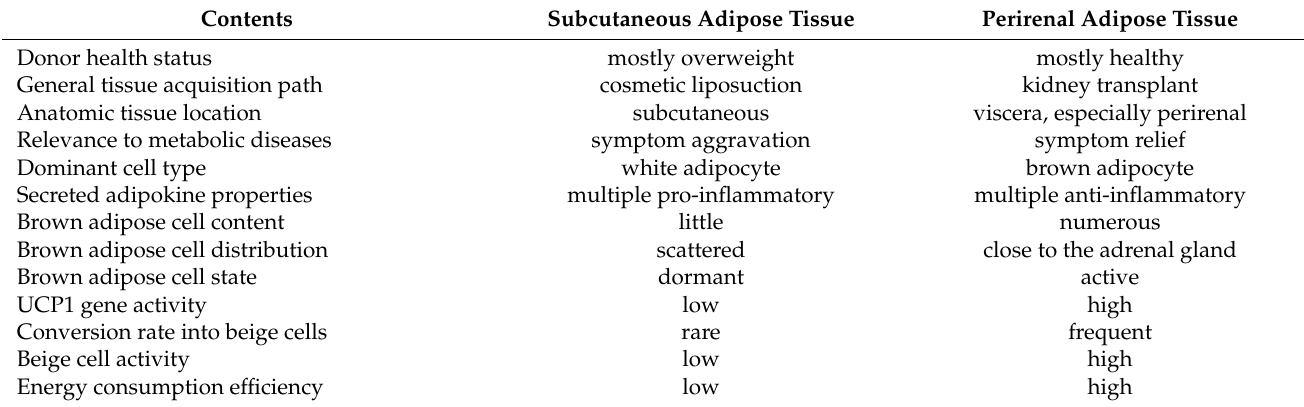
Table 2. Comparison of approximate benefits of subcutaneous and peripheral adipose